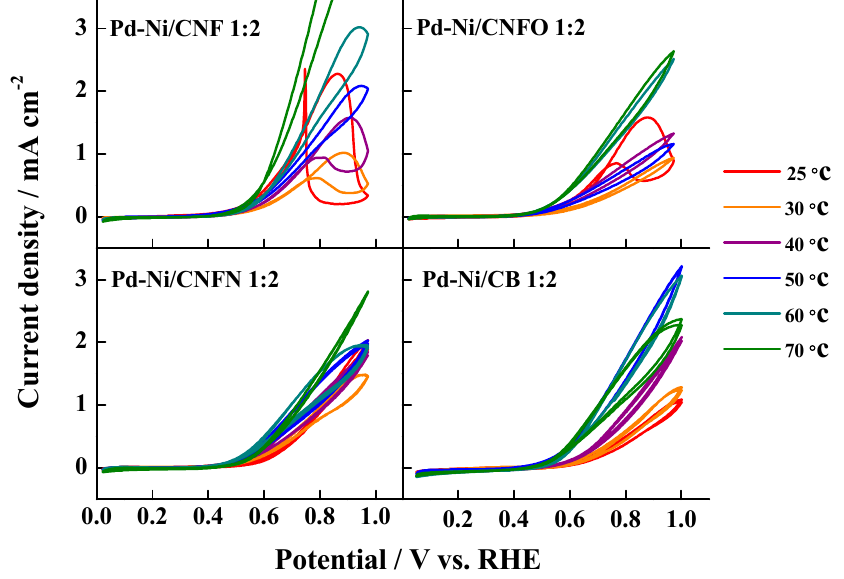
Figure 9. Methanol oxidation voltammograms for the synthesized Pd-Ni catalysts at the temperature range (20–70 ◦ C). Support electrolyte: 0.1 M KOH. Scan rate: 20 mV · s − 1 . Methanol concentration: 1.0 M. Current density vs. time curves (Figure 10) were recorded in order to evaluate the methanol oxidation at 0.6 V vs. RHE, a typical operation potential in the DMFCs. The values for these stationary methanol oxidation current densities were similar to those observed during the cyclic voltammetry experiments, demonstrating that there is no effect of the surface groups on the methanol oxidation. The increase of temperature up to 60 and 70 ◦ C induced a drop in the current densities in some catalysts, caused by either bubbles and/or movement of methanol